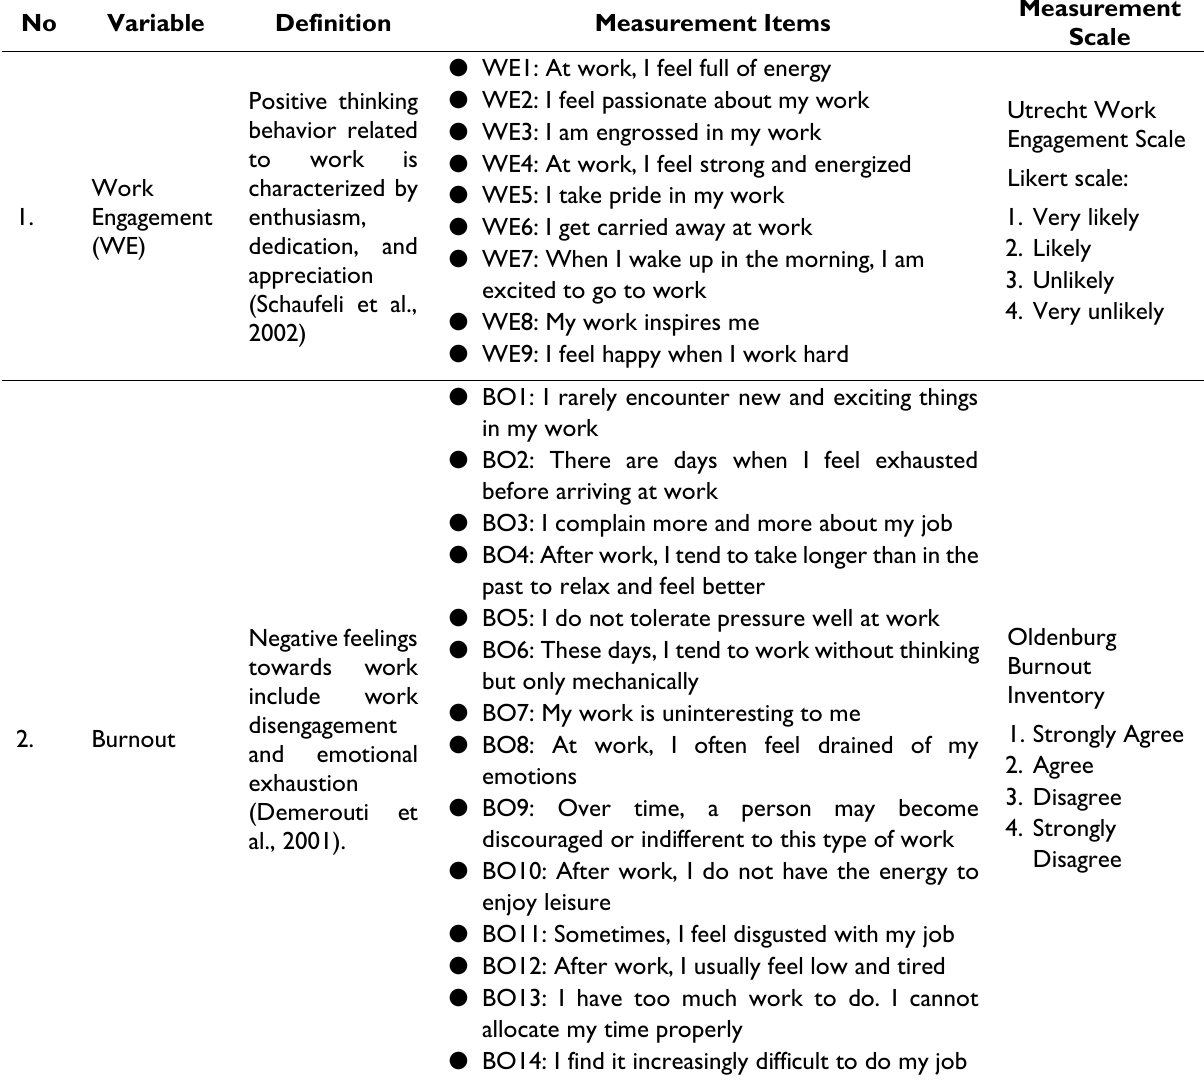
Table 1. Examples of Measurement